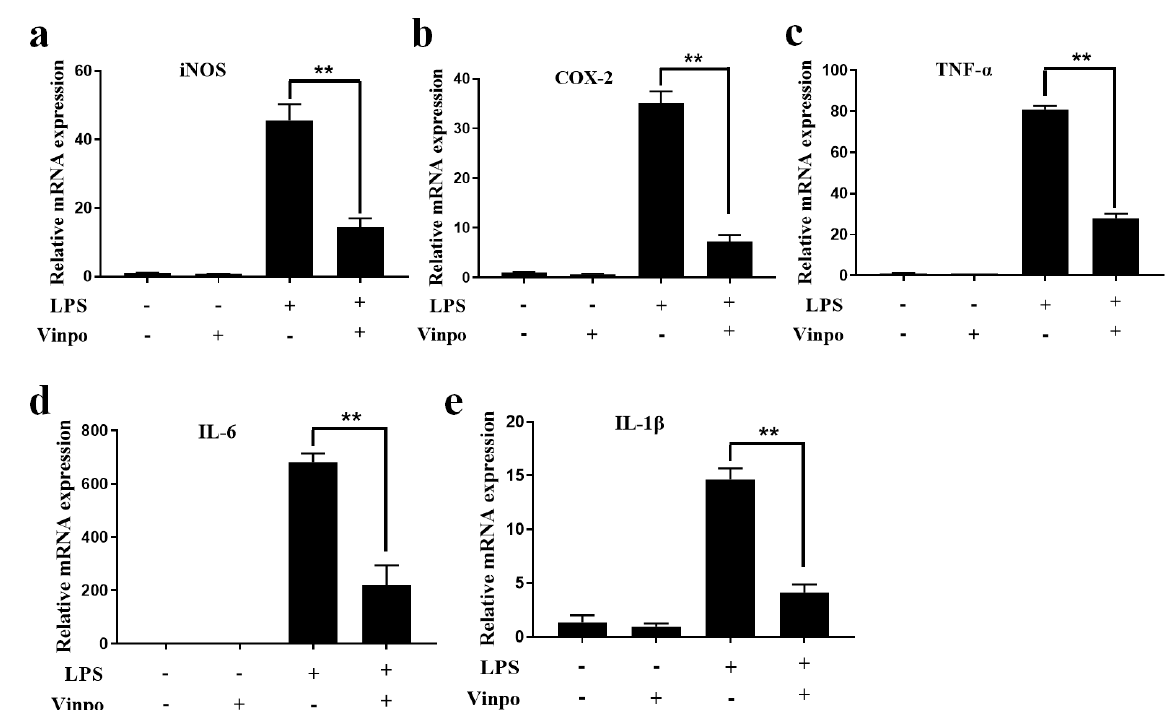
Figure 3. Vinpocetine suppressed the mRNA expression levels of the pro-inflammatory mediators in BV2 microglia stimulated with LPS. Vinpocetine suppresses the transcription and release of proinflammatory factor. BV2 cells were pretreated with vinpocetine (50 μ M) for 12h and then exposed to LPS (100 ng/mL) for 6 h. Cell lysates were collected to measure iNOS (a), COX-2 (b), TNF-α (c), IL-6 (d) and IL-1β (e) mRNA levels by qRT-PCR assays. Data are representative of three independent experiments. **P < 0.01 compared between the indicated groups.